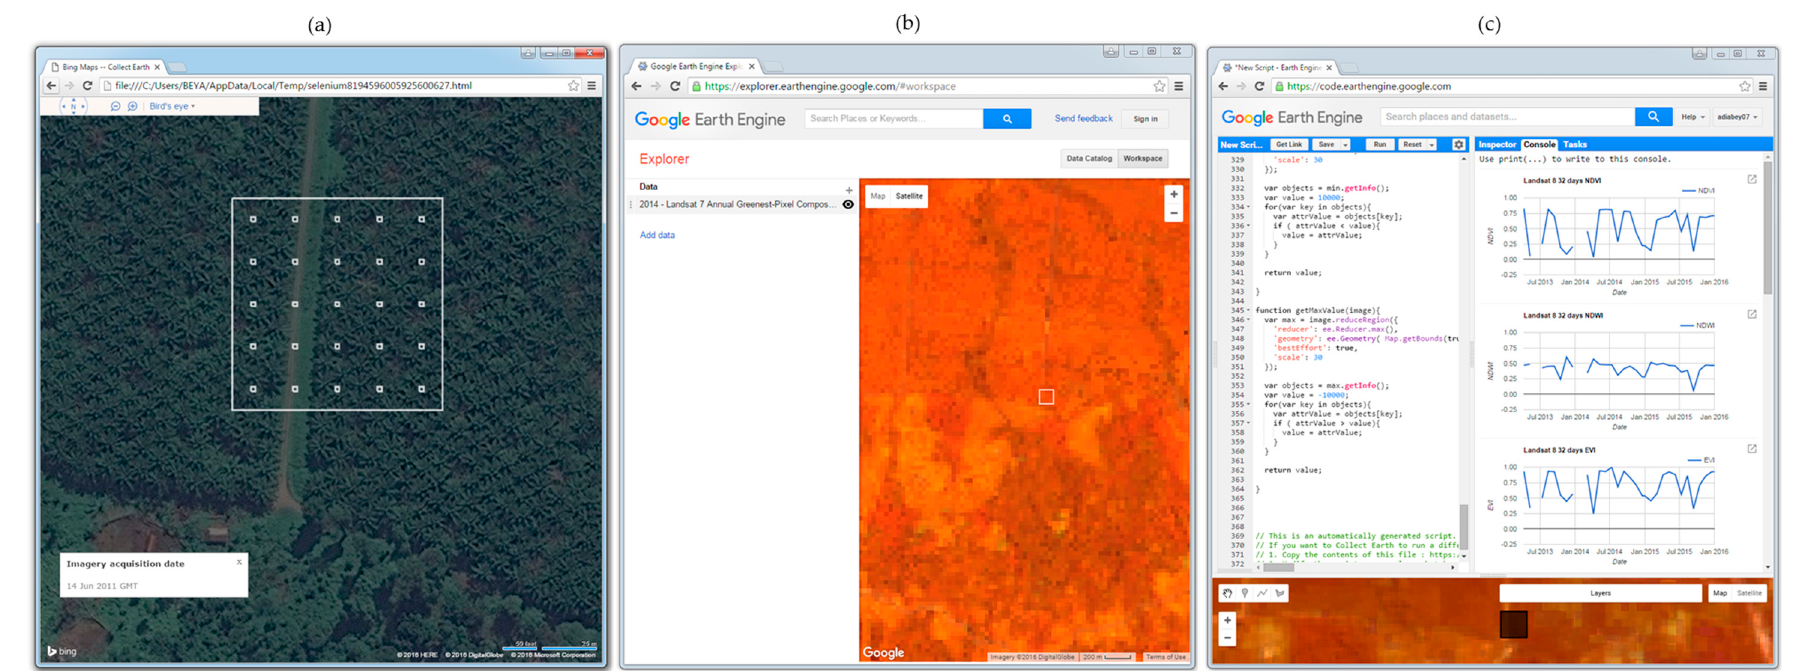
Figure 5. Geo-synchronized view of the plot at different scales in Bing Maps (Figure 1 Si-2) ( a ); Google Earth Engine (Figure 1 Si-3) ( b ) and Google Earth Engine Code Editor (Figure 1 D-a2) ( c ).